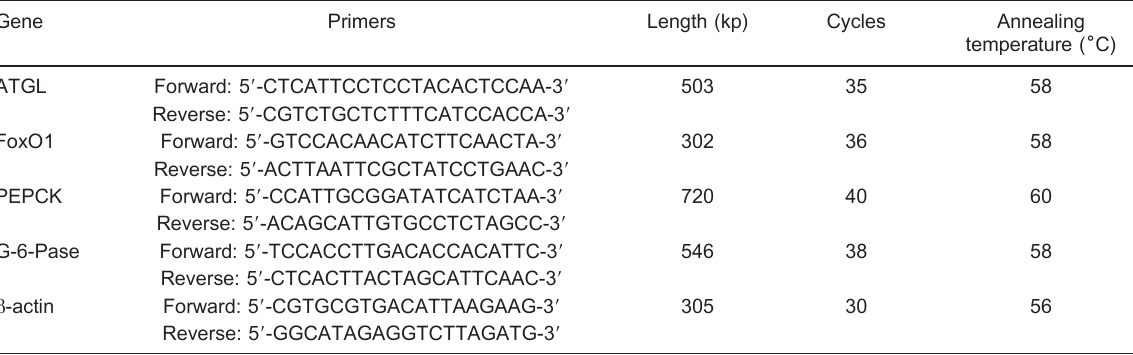
Table 1. Primers and product size for each target gene.